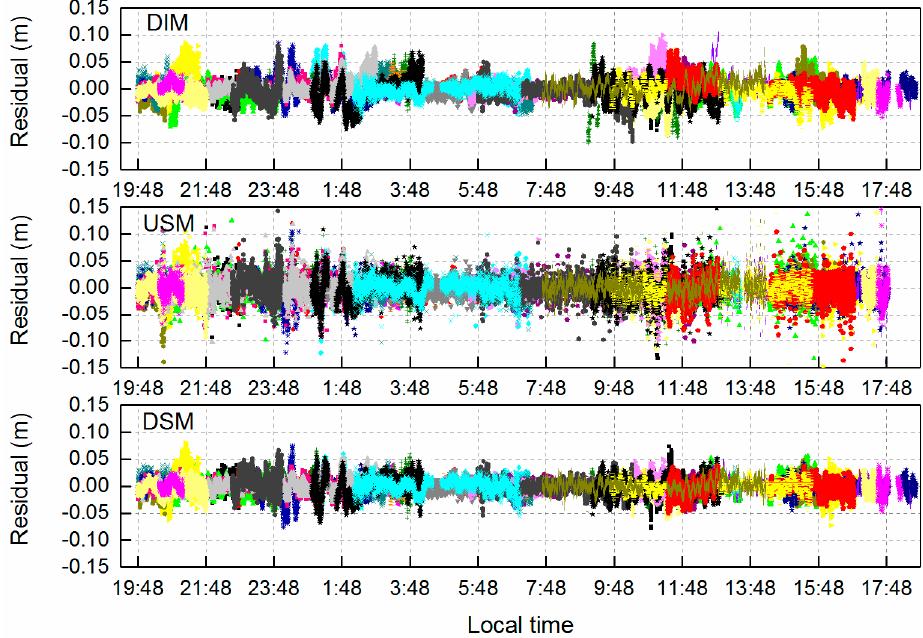
Figure 2. Time series of SD ionospheric residuals of DIM/USM/DSM in scenario A. Different colors represent SD ionospheric residuals of different satellite pairs. Table 2. Accuracy of SD ionospheric delay interpolation for different interpolation methods (cm).